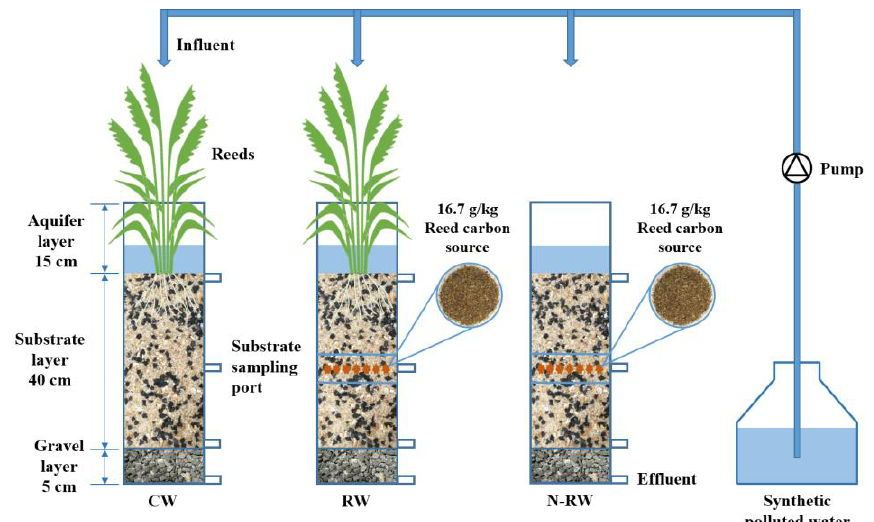
Figure 1. Schematic diagram of vertical-flow constructed wetland devices. Note: g/kg—the mass of reed carbon source per kilogram of substrate filler.